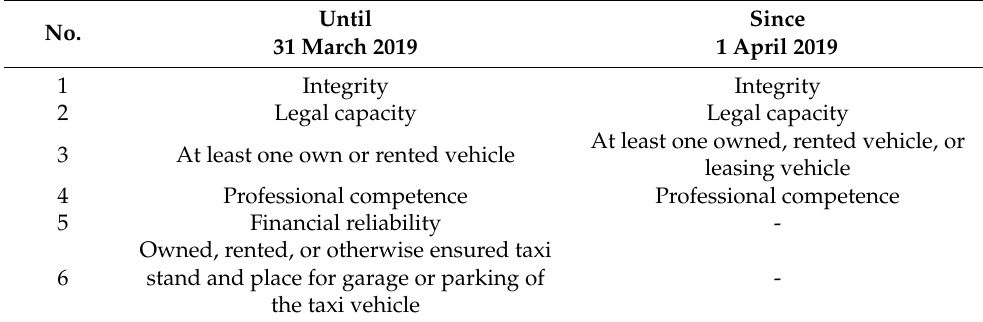
Table 1. Results of scan cycle times for monitored days according to Road Transport Act. No.